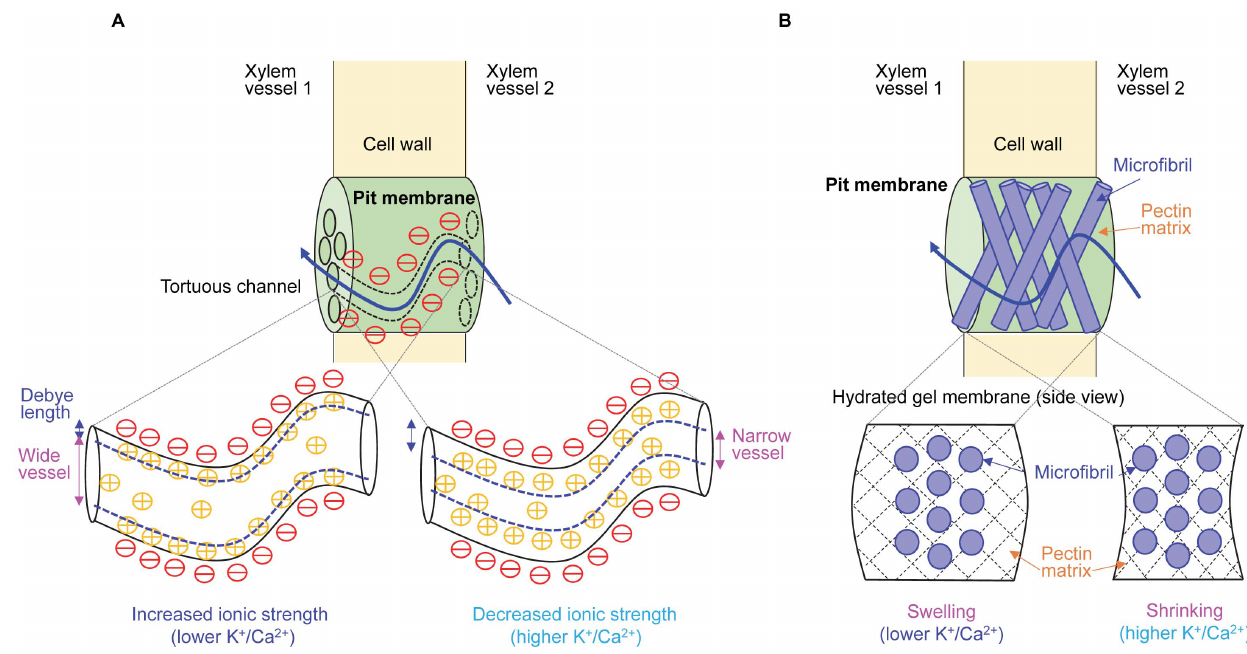
Figure 5. Putative physicochemical models for ion-mediated sap flow regulation in vascular plants. Schematic illustrations of A ) the electrostatically induced hydrodynamic layer formation model and B ) the ion-responsive hydrogel model to explain ion-mediated sap flow regulation in vascular plants. In the electrostatically induced hydrodynamic layer formation model, the ionic ratios affect the effective porous structure for control of water transport via the pit membrane. A relatively thin Debye layer formed at lower K + /Ca 2 + ratios, making a relatively wider flow path in the pit membrane, while a relatively thick Debye layer induced a narrow flow path at higher ionic ratios. In the hydrogel model and at lower K + /Ca 2 + ratios, pectins are swollen in the pit membrane with increased porosity based on Hofmeister series. This ion-mediated structural change seems to contribute to the increased flow rate through xylem vessels. At higher ionic ratios, pectins shrunk in the pit membrane with relatively decreased porosity. The effective structural changes may reduce the flow